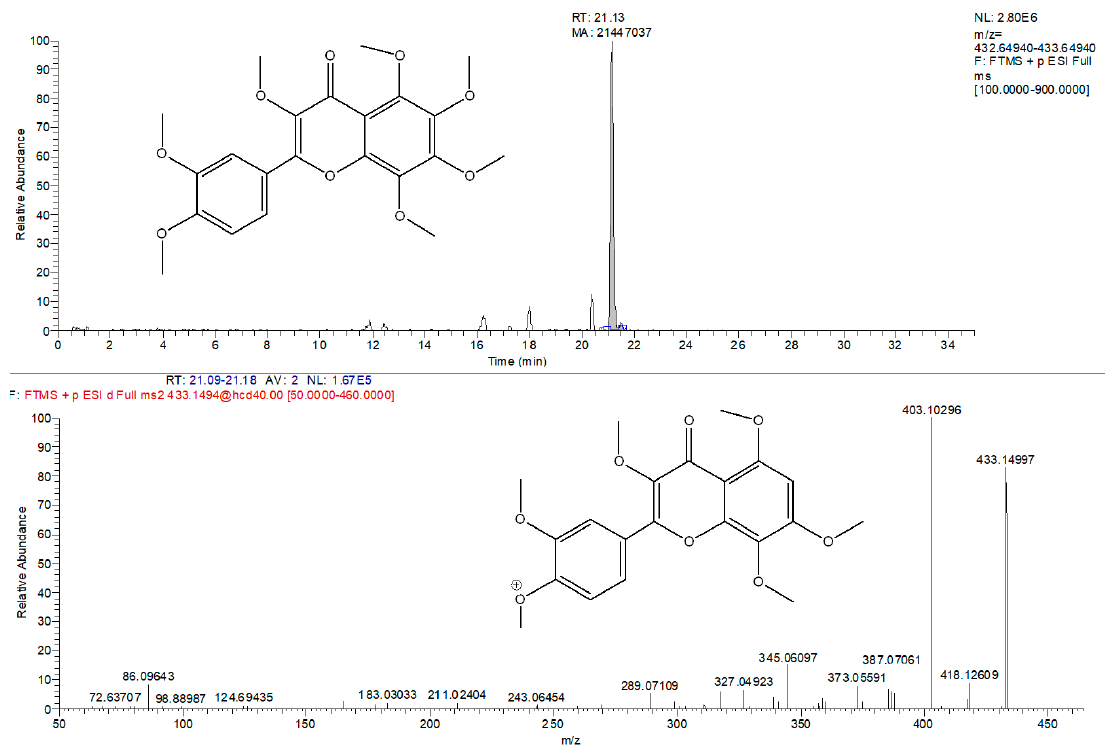
Figure 3. Tentative identification of 3-methoxynobiletin. Extracted ion chromatogram ( m/z = 433.1493) and corresponding MS/MS spectra.